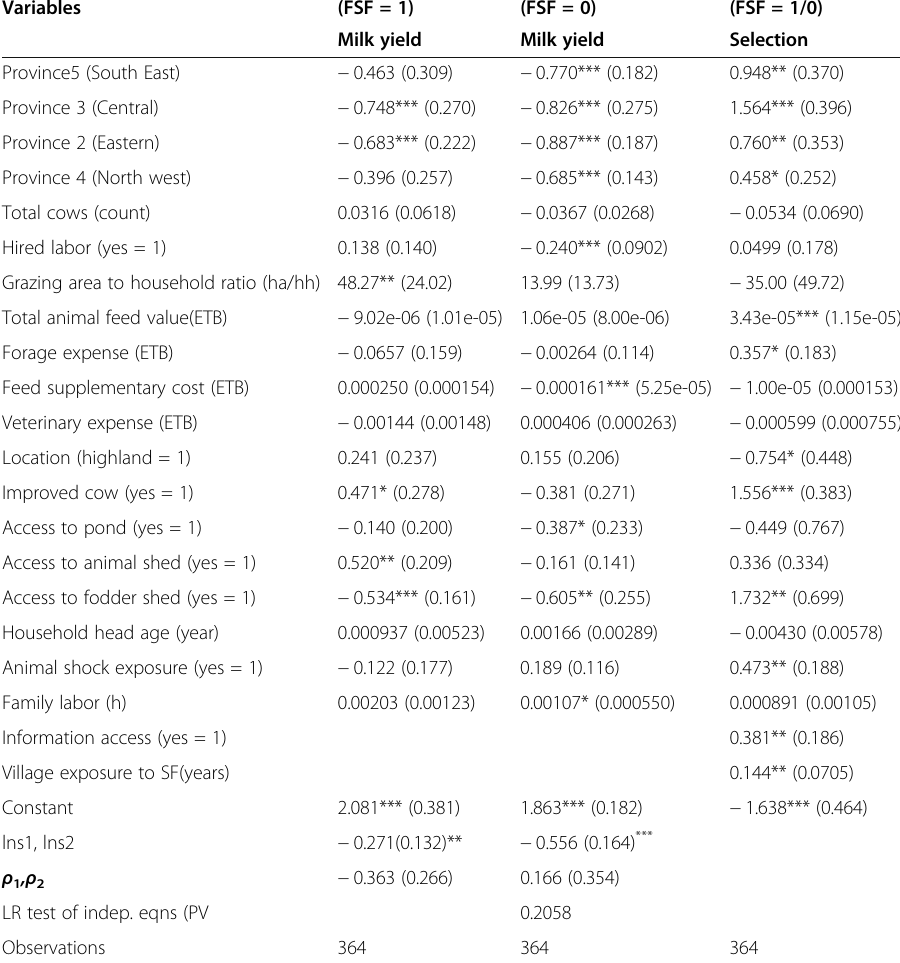
Table 2 Endogenous switching for FSF adoption and milk production